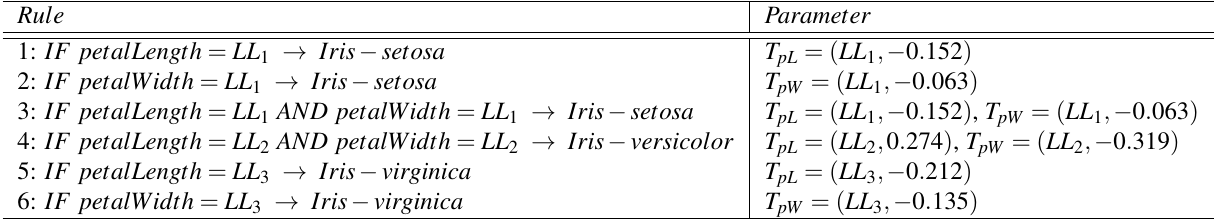
Table 5. Rules extracted for the NMEEF-SD algorithm and the tuning parameter obtained in the genetic lateral tuning for the data set Iris .